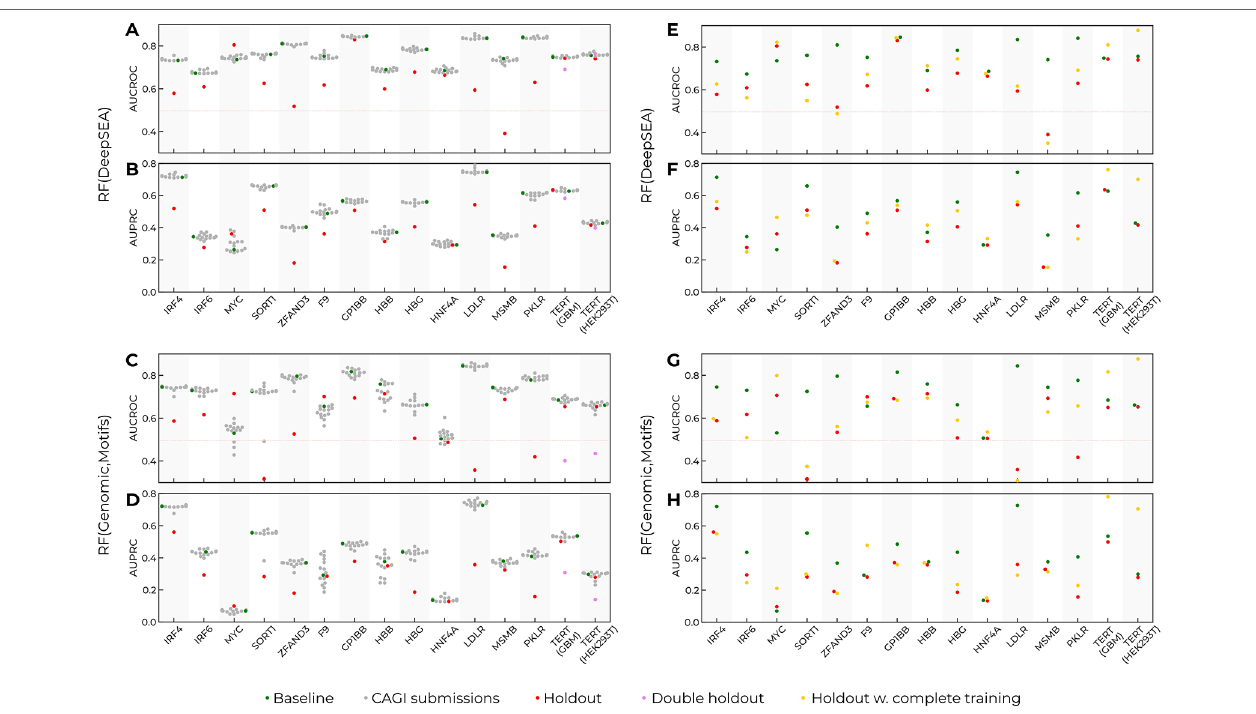
fiGURe 3 | Prediction performance drops as the data from target reporters are excluded from training. Training on the complete data improves prediction quality, but cannot compensate for the holdout of the data for single-nucleotide variants (SNVs) from the target reporter. Green dots, the baseline models trained in the CAGI setup. Grey dots, the CAGI submissions. Red dots, the models trained in the CAGI setup with the data from the target reporter held out. Violet dots, the performance for the TERT target reporter with the data from both TERT assays held out from training. Yellow dots, the models trained with the complete data from all reporters excluding the target reporter. Reporter names are given at the X-axes. (A , B) Area under precision-recall curve (AUPRC) and area under curve for receiver operating characteristic (AUCROC) for Random Forest with DeepSEA features (baseline and holdout models). (C , D) AUPRC and AUCROC for Random Forest with Genomic signal and sequence motif features (baseline and holdout models). (e , f) AUPRC and AUCROC for Random Forest with DeepSEA features (baseline, holdout, complete training models). (G , h) AUPRC and AUCROC for Random Forest with Genomic signal and sequence motif features (baseline, holdout, complete training